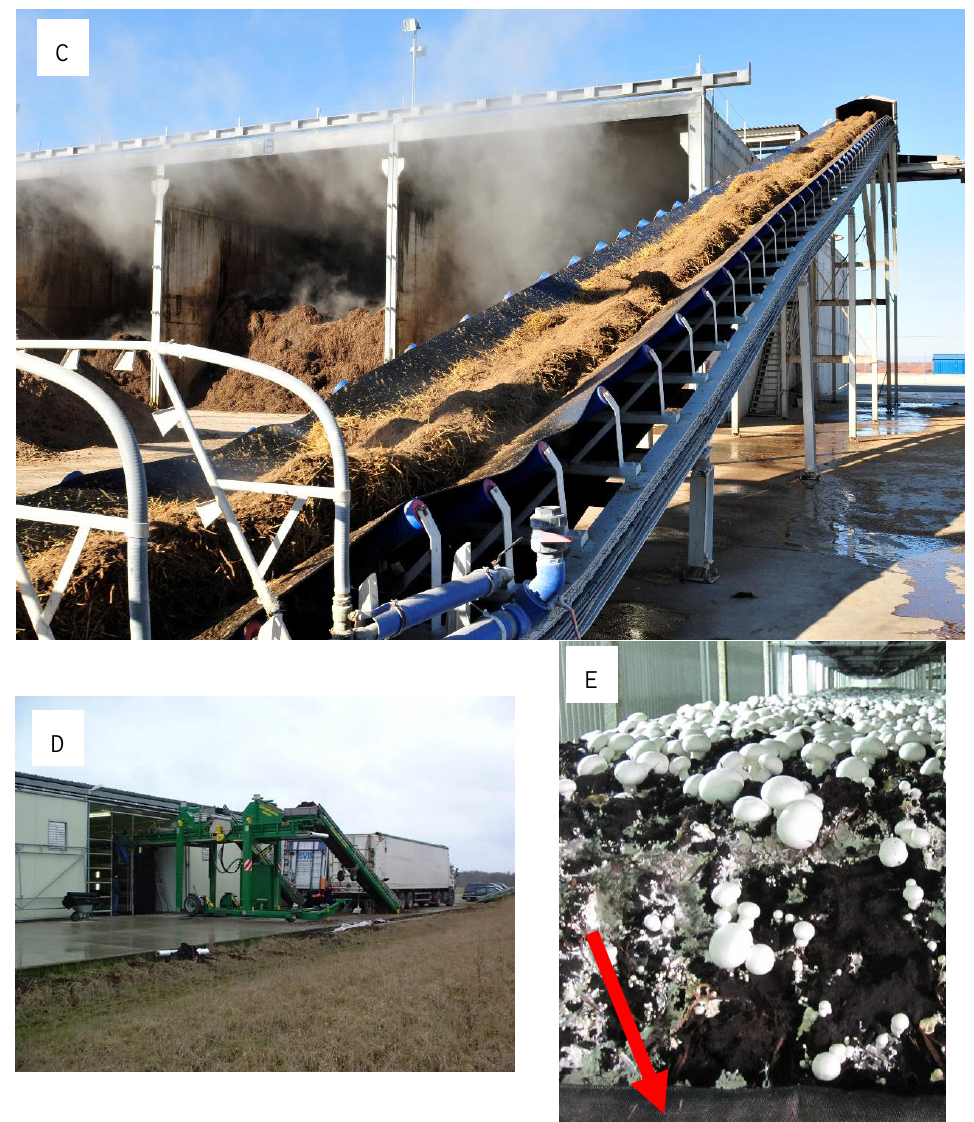
Figure 4. ( A ): Mechanical machinery used for different material mixtures, i.e., straw, SMS, manure, bran, etc., which are deposited by a tractor in phase I of composting.; ( B ): Irrigation system used to moisten the compost; ( C ): Compost being driven to bunker after being mixed and moistened; ( D ): Modern together into growing rooms. The truck with compost and the truck with casing soil from different